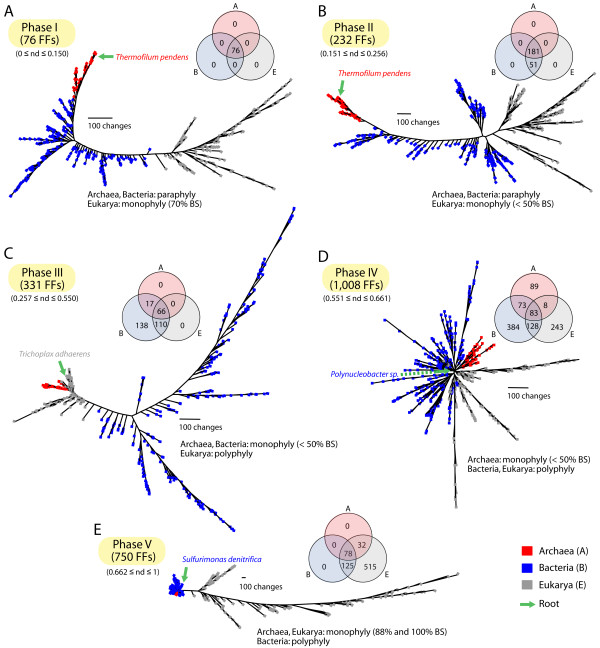
Species trees reconstructed using phase-specific FFs in 420 proteomes of free-living organisms. (A) Tree of proteomes reconstructed from the 76 FFs of phase I (tree length = 12,829 steps; CI = 0.065, RI = 0.727; g1 = -0.116). (B) Tree of proteomes reconstructed from the 232 FFs of phase II (tree length = 28,447 steps; CI = 0.056, RI = 0.708; g1 = -0.242). (C) Tree of proteomes reconstructed from the 331 FFs of phase III (tree length = 13,773 steps; CI = 0.082, RI = 0.783; g1 = -0.212). (D) Tree of proteomes reconstructed from the 1,008 FFs of phase IV (tree length = 21,804 steps; CI = 0.153, RI = 0.614; g1 = -0.356). (E) Tree of proteomes reconstructed from the 750 FFs of phase V (tree length = 47,213 steps; CI = 0.136, RI = 0.828; g1 = -0.284). Terminal leaves of Archaea, Bacteria, and Eukarya were labeled in red, blue, and gray. Venn diagrams show the distribution of FFs in the three superkingdoms for the FFs of each phase. The green arrow indicates the root position of a given tree of proteomes.